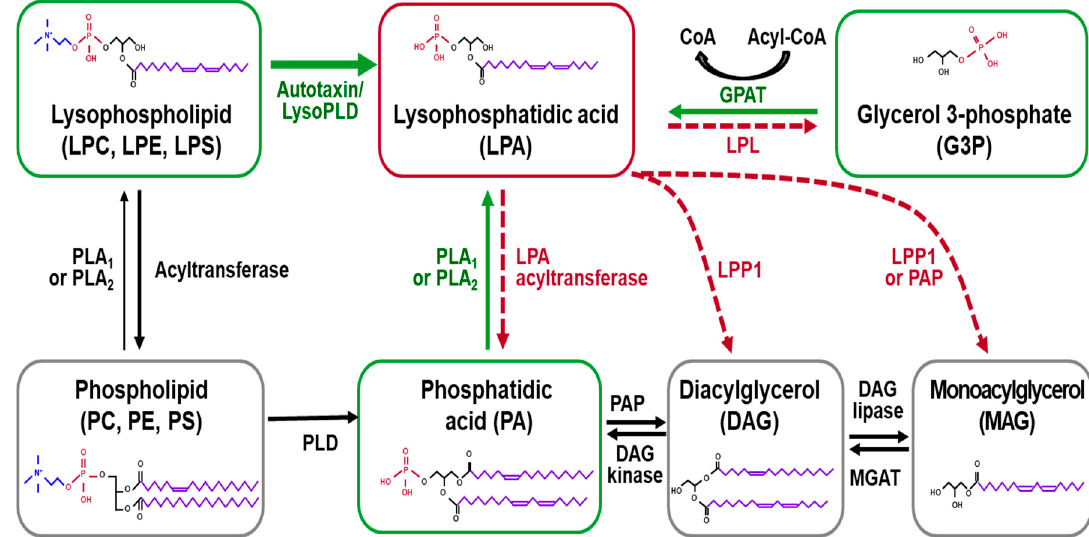
Figure 1. The enzymatic pathways of lysophosphatidic acid (LPA) synthesis and degradation. LPA can be synthesized from different precursors, including lysophospholipids, phosphatidic acid, and glycerol 3-phosphate. The enzymes and pathways involved in LPA production are indicated using green text and a green solid line, respectively. LPA is converted into either monoacylglycerol or phosphatidic acid. The enzymes and pathways involved in LPA conversion are indicated using red text and a red dotted line, respectively. Lysophosphatidylcholine (LPC), lysophosphatidylethanolamine (LPE), lysophosphatidylserine (LPS), lysophospholipase D (Lyso PLD), lysophospholipase (LPL), glycerol 3-phosphate acyltransferase (GPAT), phospholipase C (PLC), phospholipase A1 or A2 (PLA1 and PLA2), diacylglycerol (DAG), monoacylglycerol (MAG), MAG acyltransferase (MGAT), lipid phosphate phosphatase 1 or 2 (LPP1 and LPP2), phosphatidate phosphatase (PAP), phosphatidylcholine (PC), phosphatidylethanolamine (PE), phosphatidylserine (PS), and phospholipase D (PLD).